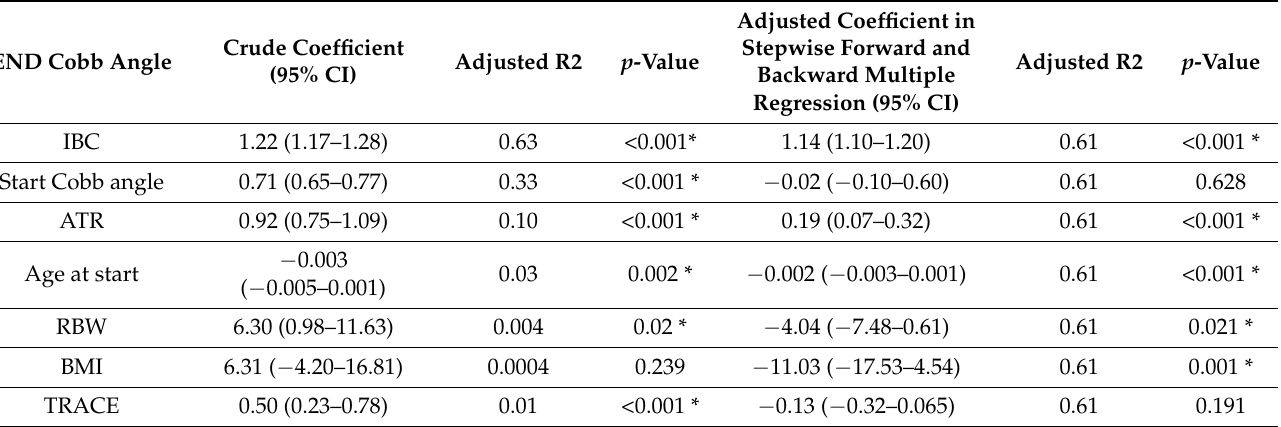
Table 3. The crude and adjusted coefficients of the linear multivariable regression model after the regression imputation procedure. RBW = real brace wear, IBC = in-brace correction, in Cobb degrees difference, and in percentage. * Level of significance set to